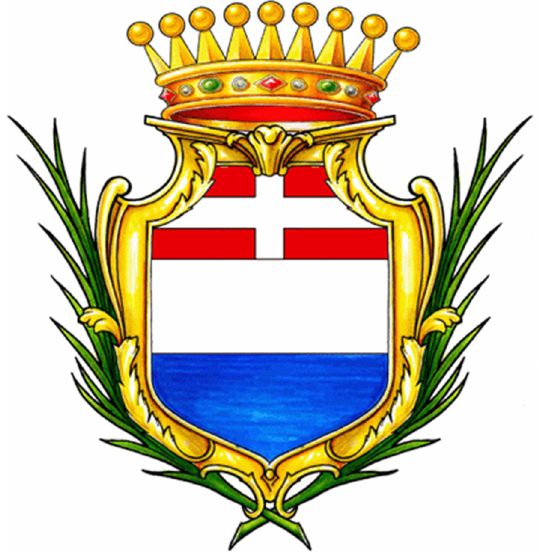
Figure 12. Oristano coat of